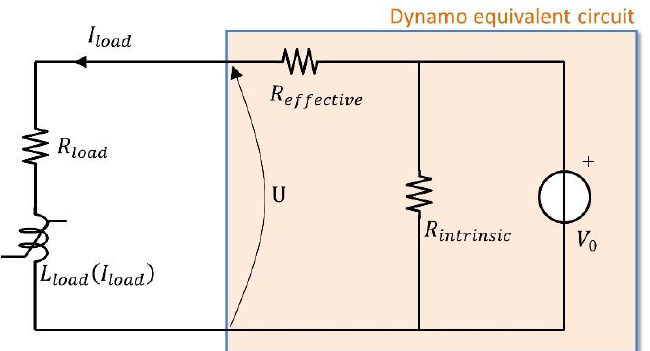
Figure 6. V vs. I relation, power dissipated vs. I load , efficiency vs. I load and power delivered to the field winding vs. I load of the dynamo flux pump.